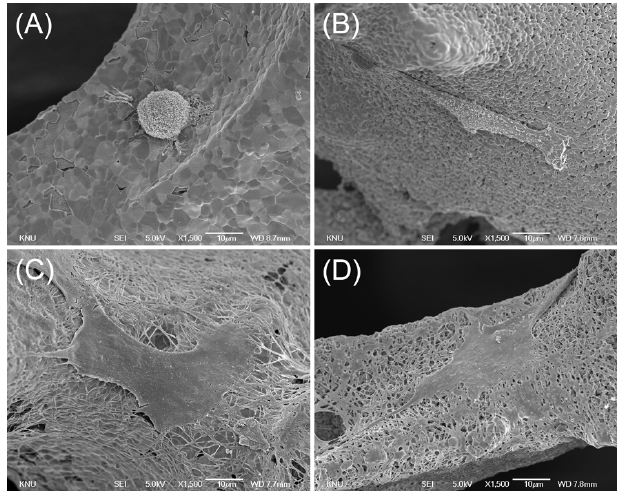
Figure 5. SEM images of MG63 cells cultured on ( A ) Control; ( B ) MP; ( C ) COL; ( D ) MP/COL (1,500×, bar = 10 μ